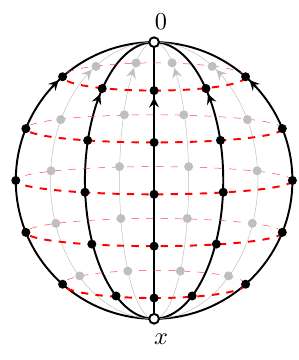
Figure 4 . A \wheel" Feynman graph with M frames and J spokes whose external legs have been joined at the point x ( M = 5 and J = 9 in this